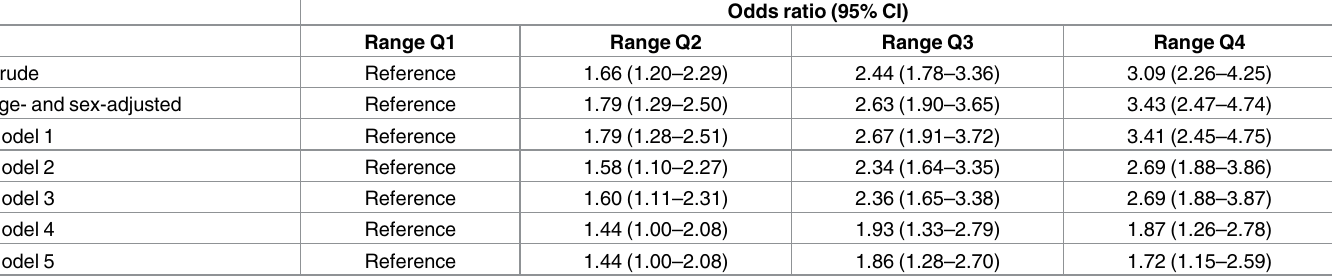
Table 4. Multivariable binary logistic regression analyses of the predictors of poor functional outcomes at 3 months after stroke onset, according to the range quartile.